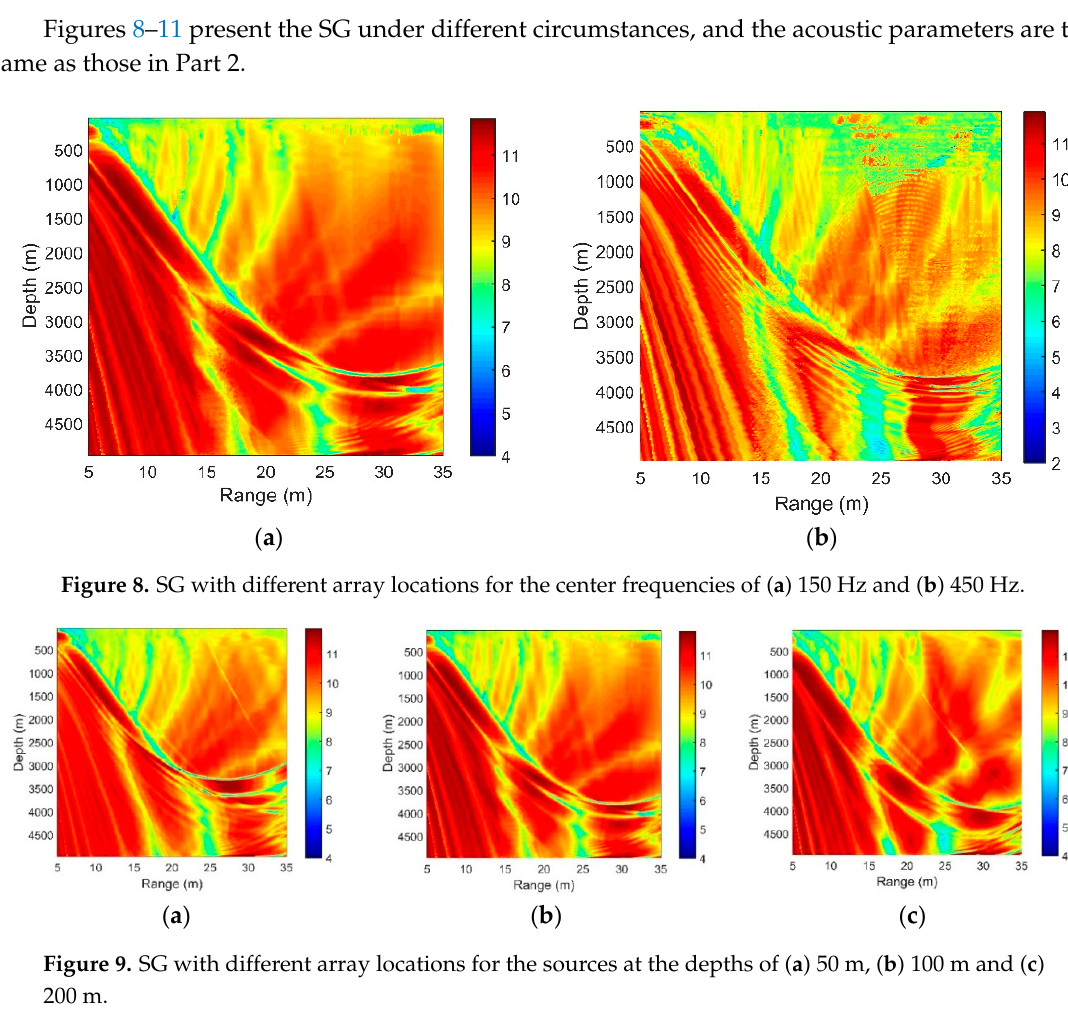
Figure 9. SG with different array locations for the sources at the depths of ( a ) 50 m, ( b ) 100 m and ( c ) 200 m.